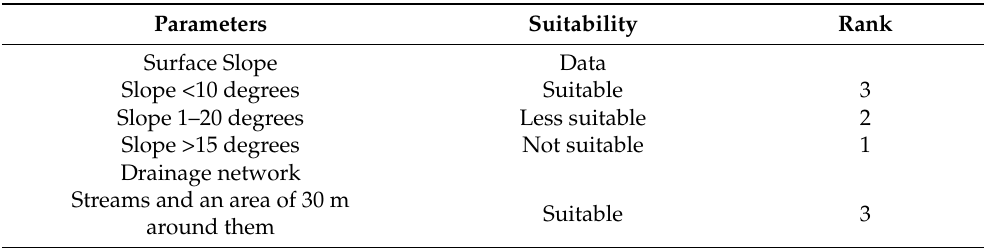
Table 1. Parameters, their suitability, and ranks for selecting suitable sites for farm ponds. Surface slope, drainage network, settlement, roads, runoff volume, and rainwater harvesting result param- eters were classified and weighted, and ranks were assigned in order to perform overlay analysis. The suitability and ranks were set based on IMSD (1995), INCOH (1995), and FAO (2003)